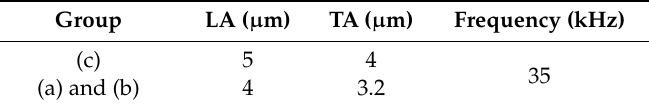
Table 3. Ultrasonic parameters.